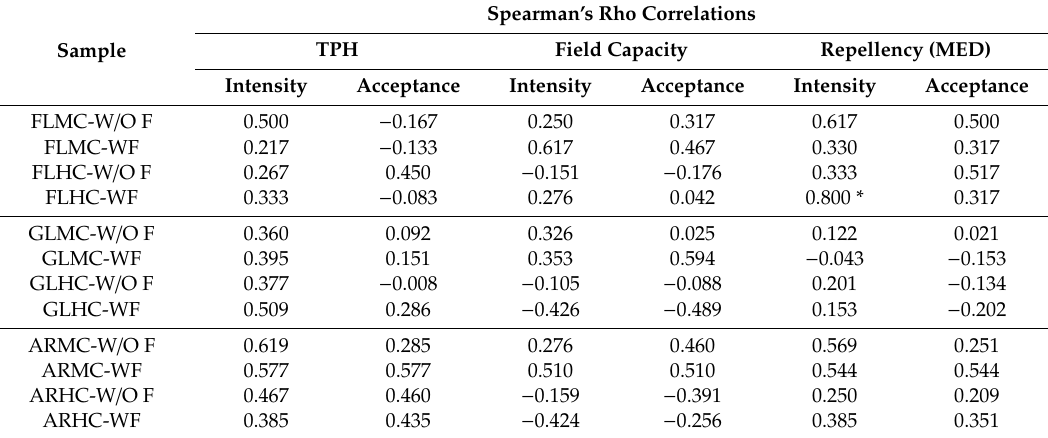
Table 3. Correlations of odor perception with Total Petroleum Hydrocarbons (TPH), Field Capacity and Water